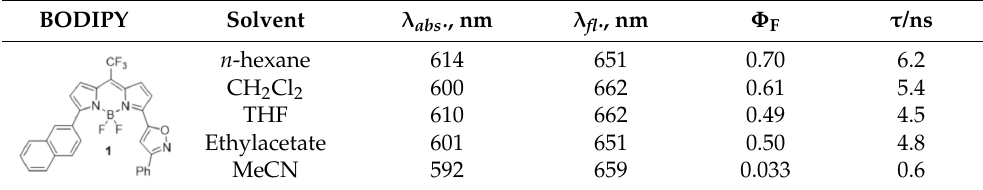
Table 1. Spectroscopic and photophysical characteristics of compound 1 in different